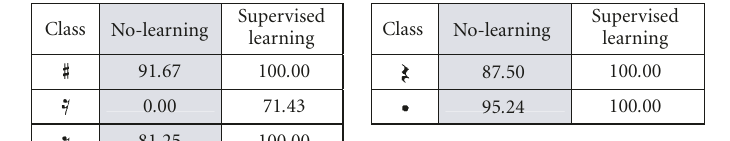
Table 7: Recognition rates before and after supervised learning (example 2, 2 sheets, 21 staves) . The global recognition rate is increased from 95 . 64% to 98 . 09%, and the added symbol rate is decreased from 3 . 13% to 2 .